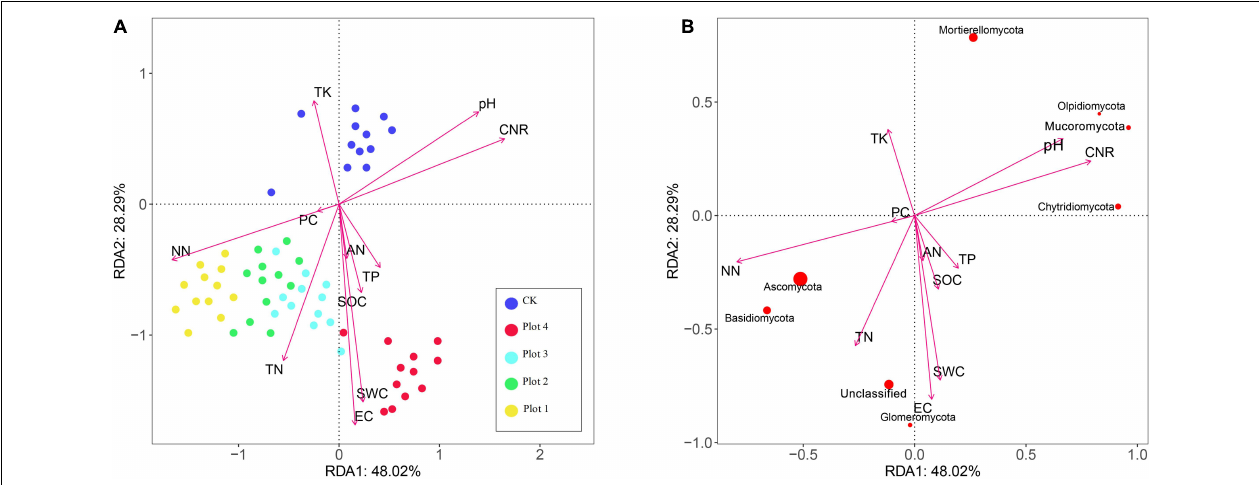
FIGURE 4 | Redundancy analysis (RDA) of the relationships between soil physicochemical properties and fungal communities ( p < 0.01). (A) Shows the relationship between soil physicochemical factors and soil sample distribution, and (B) shows the relationship between the major fungal phyla and soil physicochemical factors. The size of the point represents the abundance of the species. Percent variability explained by each principal component is shown in parentheses after each axis legend. CK represents soil in a reference plot with native Hippophae rhamnoides vegetation on the mine site, and Plot 4, Plot 3, Plot 2, and Plot 1 represent soils with Hippophae rhamnoides vegetation reclaimed on the mine site in 2007, 2012, 2015, and 2017,